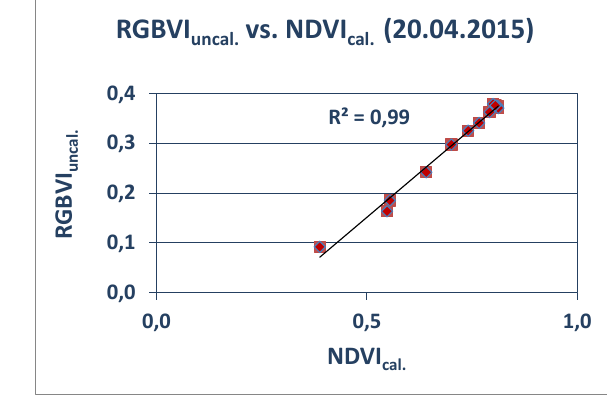
Figure 5. Evaluation of the RGBVI uncal. vs. NDVI cal. for the N experiment for April 20 th ,